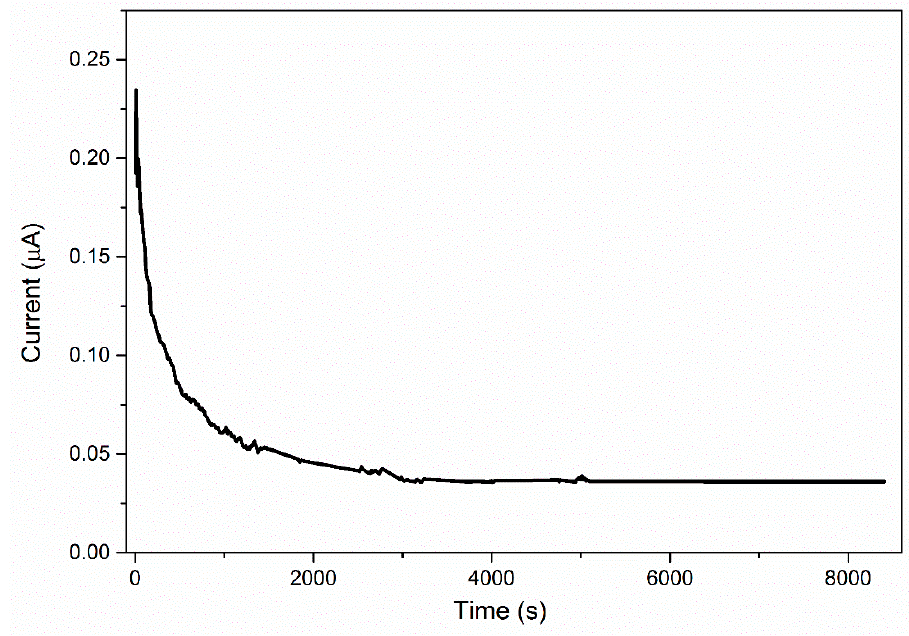
Figure 5. Normalized polarization current versus time for PUA/LiClO 4 /EC (9 wt. %) electrolyte.